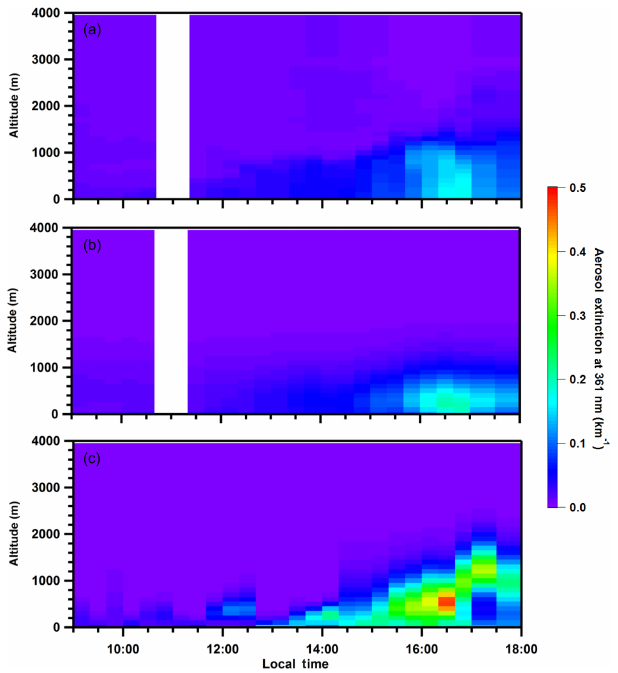
Figure 13. The 23 August vertical profiles of aerosol extinction (361nm) from S ratio of 44sr within the plume > 14:30LT: aver- aged lidar (a) , smoothed lidar (b) , and MAX-DOAS retrieved mea- surements (c)